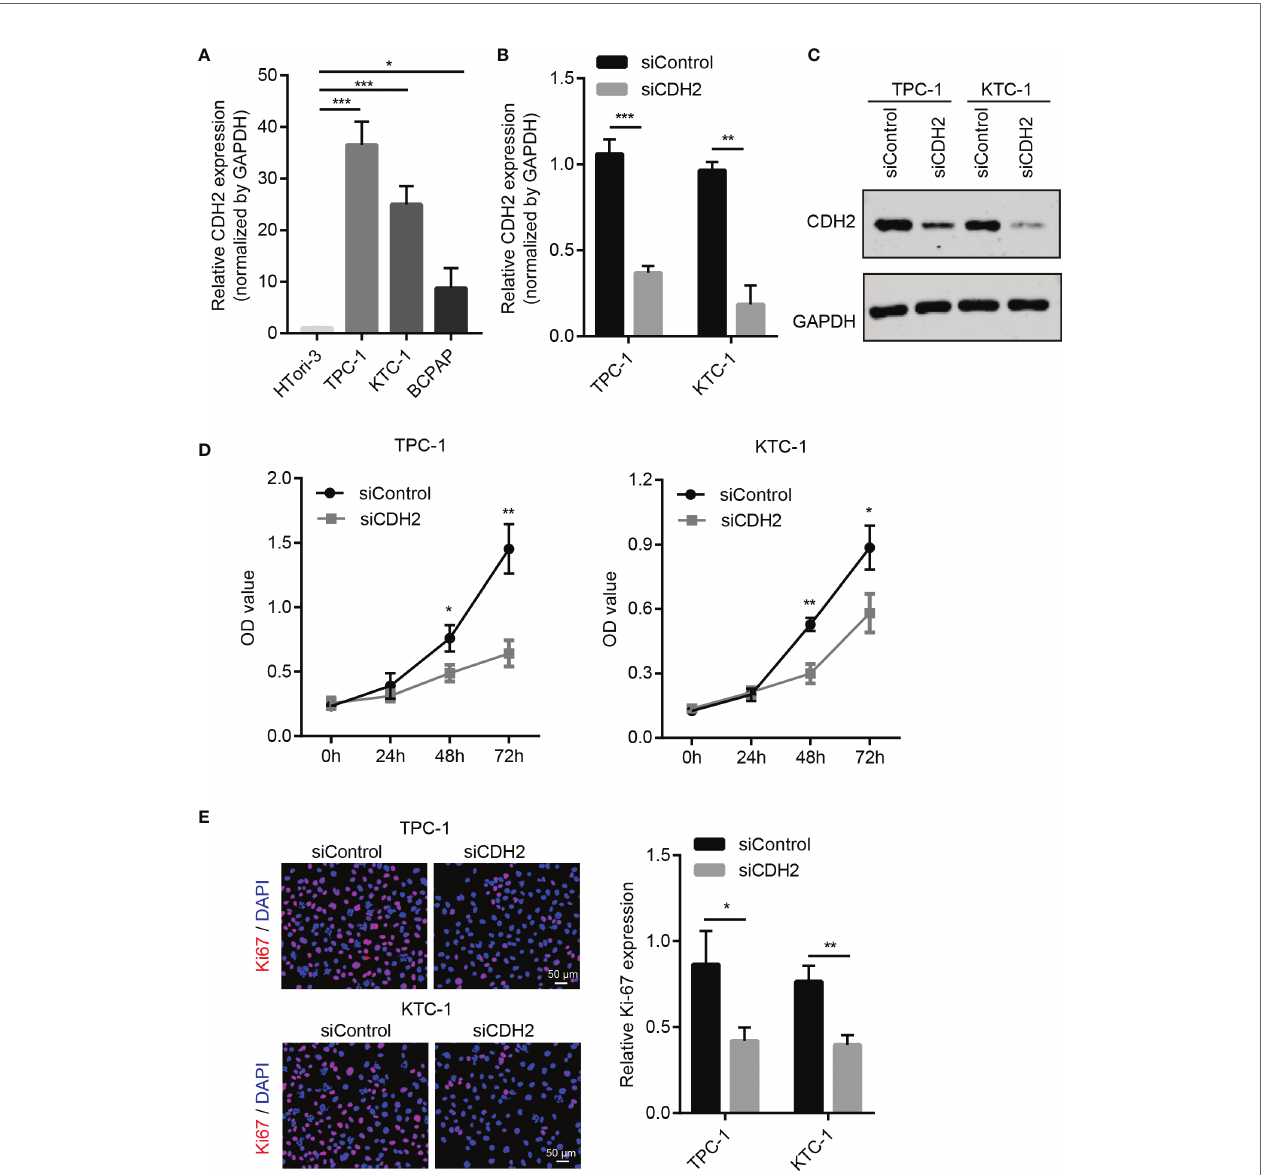
FIGURE 2 | CDH2 promotes the growth of THCA cells. (A) The mRNA expression of CDH2 in human normal thyroid cells HTori-3 and THCA cell lines (TPC-1, KTC-1 and BCPAP) by qPCR assay. (B) After transfection with siRNA, the expression levels of CDH2 were examined using qPCR assay. (C) The protein levels of CDH2 after transfection with siRNA were detected by western blot assay. (D) After knocking down CDH2 expression, the proliferation ability of THCA cells TPC-1 and KTC-1 was signi fi cantly decreased using CCK8 assay. (E) After knocking down CDH2 expression, the Ki67 expression was tested by Immuno fl uorescence assay. *P < 0.05; **P < 0.01; ***P <